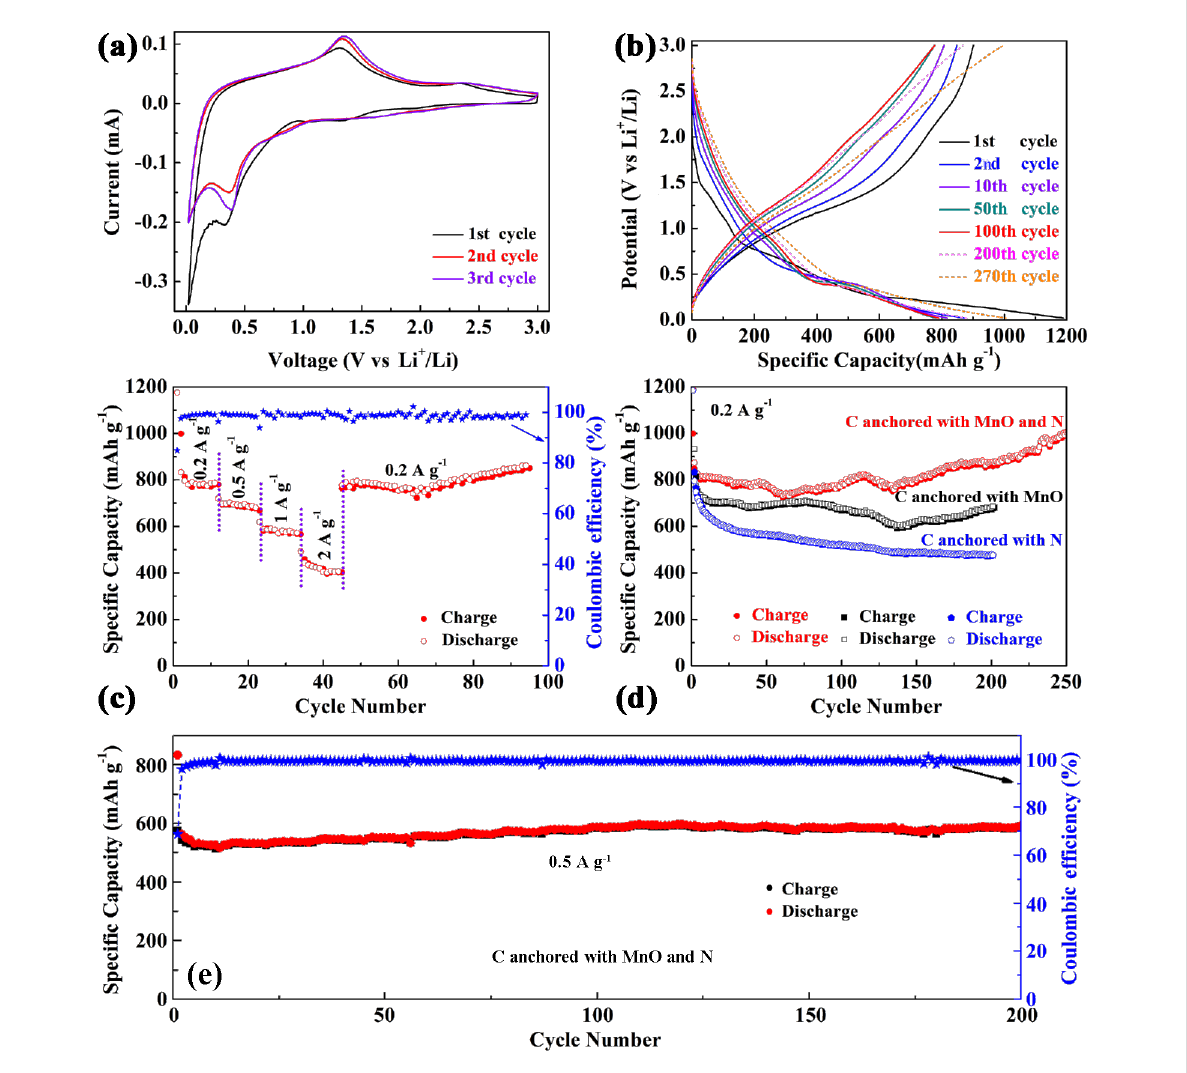
Figure 3: (a) Cyclic voltammetry curves, (b) galvanostatic discharge–charge profiles, (c) rate capacity, and (d, e) cycling performance of the network of spindle-like carbon nanofibers anchored with MnO and